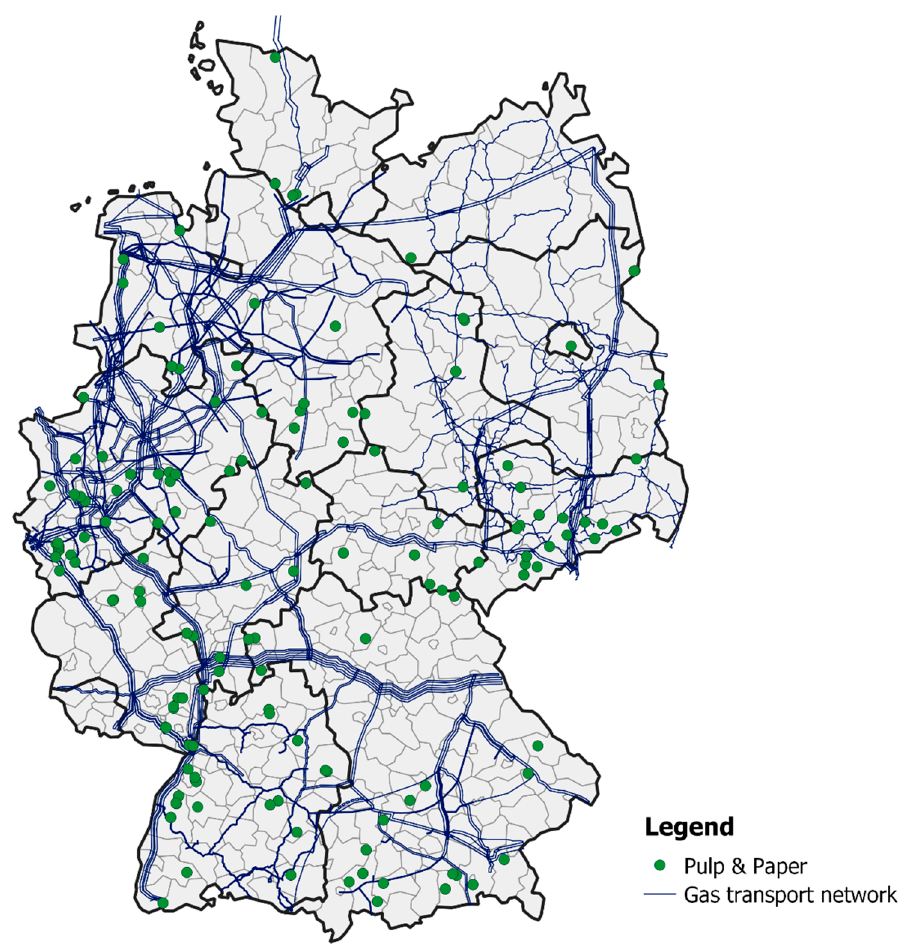
Figure 5. Pulp and paper production sites in combination with the current gas transportation network. Based on [26,34] and updated from [27].